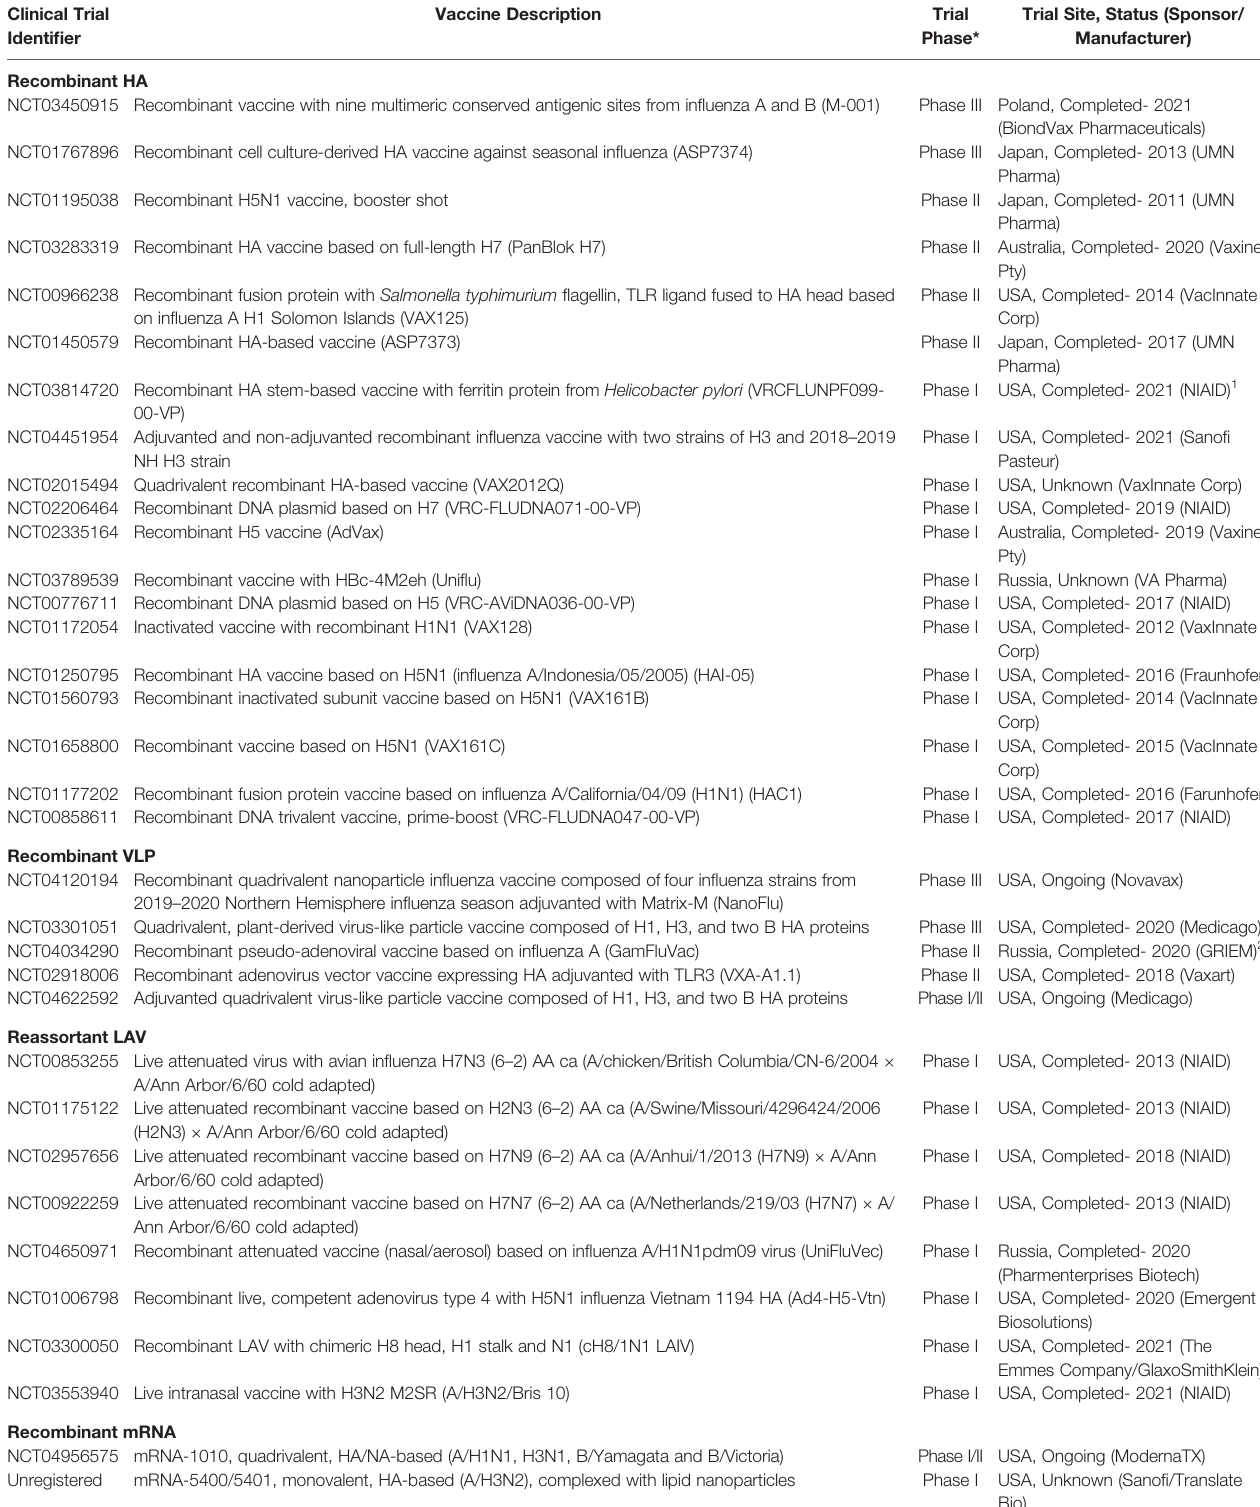
TABLE 2 | Clinical trials for HA-based recombinant vaccines registered in clinicaltrials.gov for the last decade as of April 14, 2022. Clinical Trial Identi fi